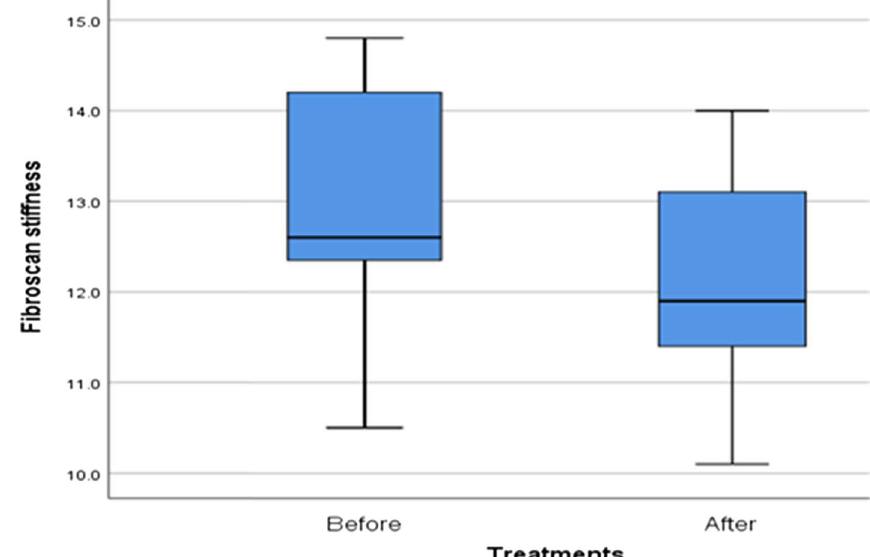
Fig. 2 The liver stiffness Boxplot between before‑ and after‑treatment in patients within < 10 KPa